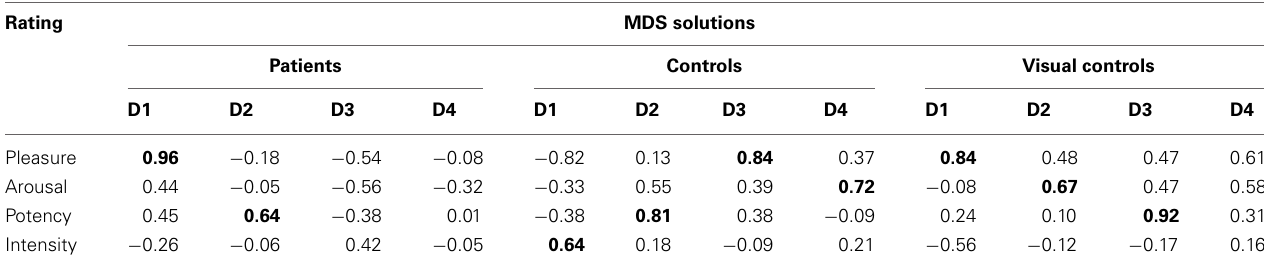
Table 2 | Correlations between independent ratings on pleasure, arousal, potency, and intensity and MDS